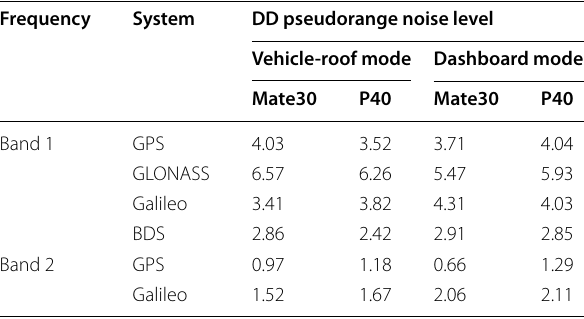
Table 2 Statistic results on the noise levels of GPS, GLONASS, Galileo and BDS dual-frequency DD pseudoranges of the experimental smartphones in the vehicle-roof mode and dashboard mode (unit: